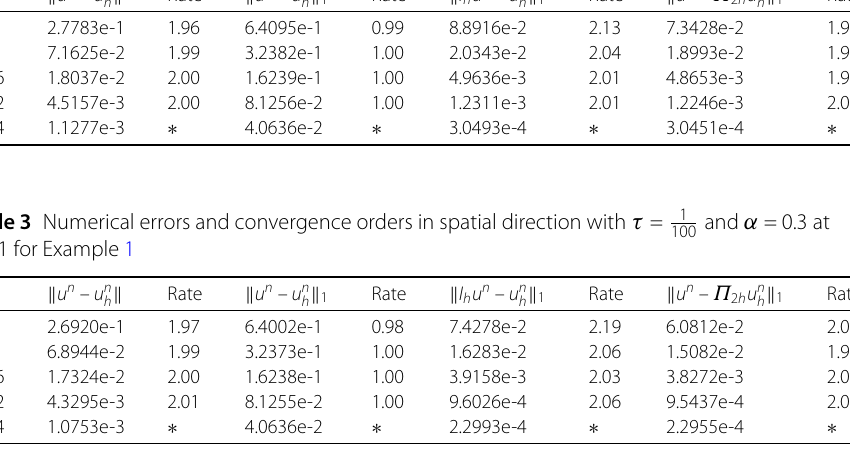
Table 2 Numerical errors and convergence orders in spatial direction with τ = 1 T = 1 for Example 1 h